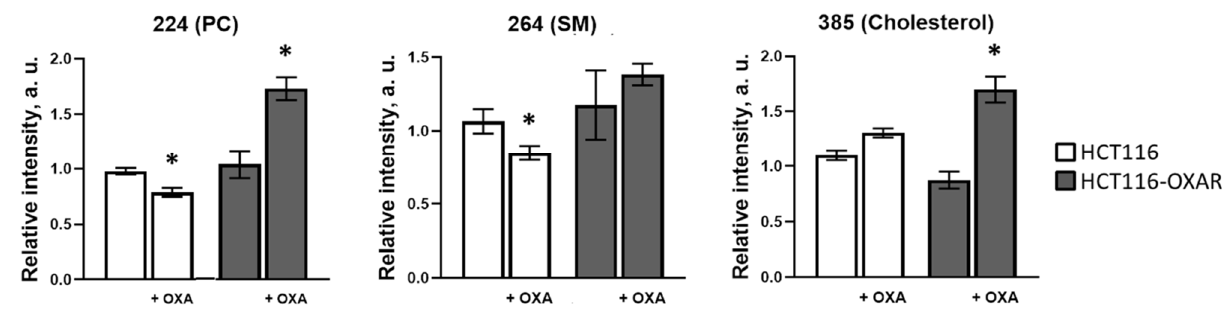
Figure 7. ToF-SIMS analysis of lipid composition of oxaliplatin-sensitive HCT116 and resistant HCT116-OXAR tumors treated with oxaliplatin and untreated controls. Oxaliplatin was injected at 7.5 mg/kg, seven doses for two weeks. Phosphatidylcholine (PC) ( m/z 224), sphingomyelin (SM) ( m/z 264) and cholesterol ( m/z 385) ion yields were obtained in positive ions. Mean ± SEM, n = 4 tumors. *, p ≤ 0.05 with untreated HCT116 tumors.